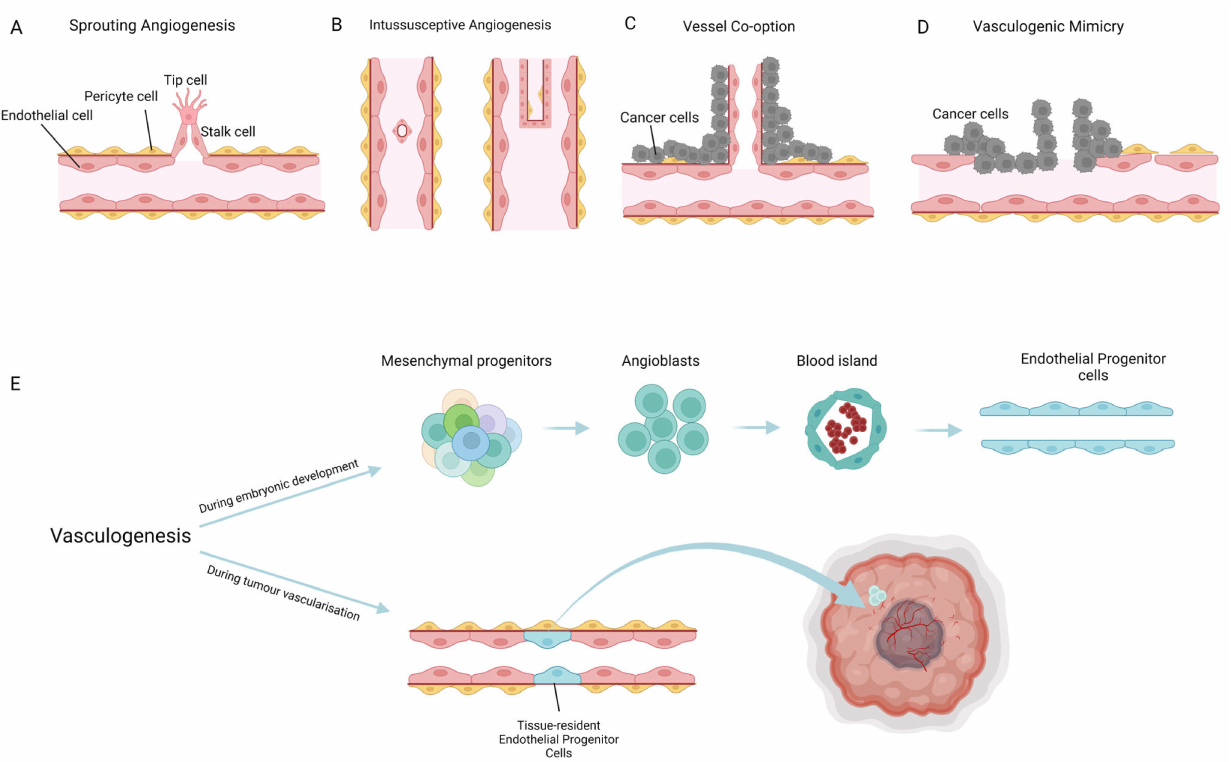
Figure 1. Mechanisms of blood vessel formation in melanoma. ( A ) Sprouting angiogenesis: formation of blood vessels from existing blood vessels. ( B ) Intussusceptive angiogenesis: formation of blood vessels by splitting a blood vessel into two. ( C ) Vessel co-option: melanoma cells relocate along the abluminal surface of the vessels. ( D ) Vasculogenic mimicry: melanoma cells remodel and form looping patterns and channels mimicking the vasculature. ( E ) Vasculogenesis: formation of de novo blood vessels from EPCs. Vasculogenesis occurs during embryonic development from angioblasts and during adulthood and pathological conditions, such as tumour vascularization, from tissue-resident endothelial progenitor cells. Created with